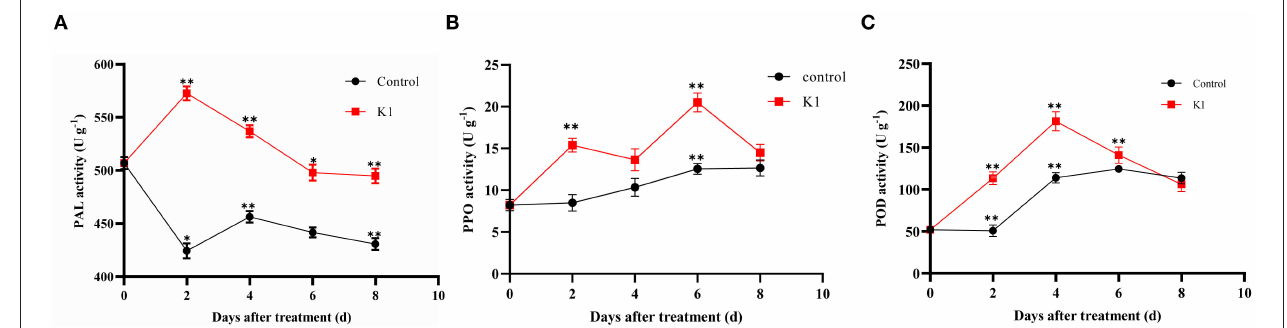
FIGURE 8 | (A–C) Effects of K1 suspension on defense related enzyme activities of grapes. Grapes were treated with K1 suspension at the concentration of 10 8 CFU ml − 1 . Grapes inoculated with 20 µ l double distilled water as control. Error bars represent standard error of the mean. Statistical significance was determined according to independent sample t -test. * and ** indicate significant differences at p < 0.05 and p < 0.01,